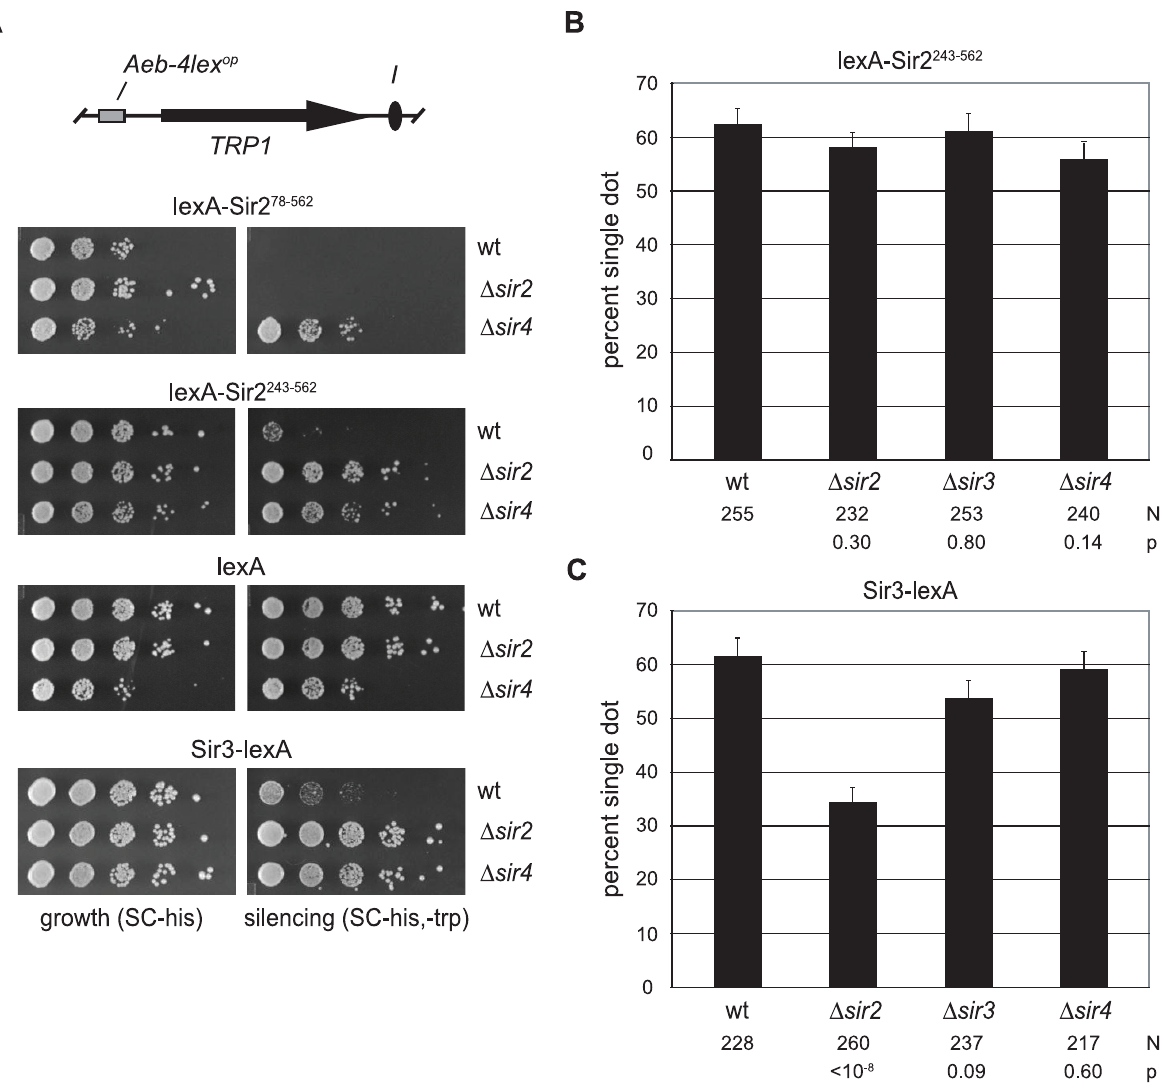
Figure 2. Cohesion by tethered Sir2 does not require other Sir proteins. A ) Silencing assays for tethered Sir2 constructs. Strains GA-2050 ( wt ), CSW98 ( D sir2 ) and CSW157 ( D sir4 ) expressing lexA-Sir2 78–562 (pCSW22), lexA-Sir2 243–562 (pCSW21), lexA alone (pBTM116H) or Sir3-lexA (pCSW17) were spotted on SC-his (growth) and SC-trp,-his plates (silencing). In the D sir4 strain, high expression of the lexA-Sir2 constructs caused a slight growth defect, as reported previously [77]. To compensate, the cell density of D sir4 isolates bearing lexA-Sir2 constructs was concentrated 10-fold before plating. B ) Cohesion of HMR circles by lexA-Sir2 243–562 in silencing-deficient mutants. Strains CSW18 ( wt ), CSW42 ( D sir2 ), CSW85 ( D sir3 ) and CSW43 ( D sir4 ) were transformed with pCSW21. C ) Cohesion of HMR circles by Sir3-lexA. Strains CSW19 ( wt ), CSW42 ( D sir2 ) and CSW85 ( D sir3 ) and CSW43 ( D sir4 ) were transformed with a plasmid expressing Sir3-lexA (pCSW14).